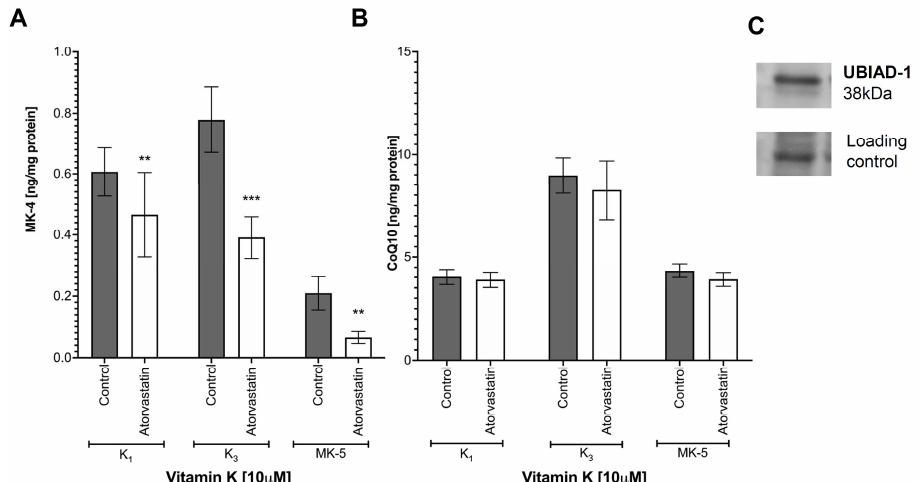
Figure 4. The inhibition of endogenous MK-4 synthesis by atorvastatin in RAW 264.7 cells. To measure MK-4 ( A ) and Figure 4 CoQ10 ( B ) levels, cells were incubated 48 h with 10 µ M vitamins K 1 , K 3 and MK-5 in the presence or the absence of 1 µ M atorvastatin. Then, the concentration of endogenous MK-4 and CoQ10 were measured in cell lysates using UHPLC-MS/MS. Data are shown as means of three independent experiments and technical replicates ( n = 9). Statistical significance was evaluated by two-way ANOVA followed by Sidak’s post hoc multiple comparisons using GraphPad Prism 9 software. The symbols ** and *** indicate statistical significance at p < 0.01 and 0.001, respectively. To confirm the presence of UBIAD-1 protein in RAW 264.7 cells, a Western blot was performed ( C